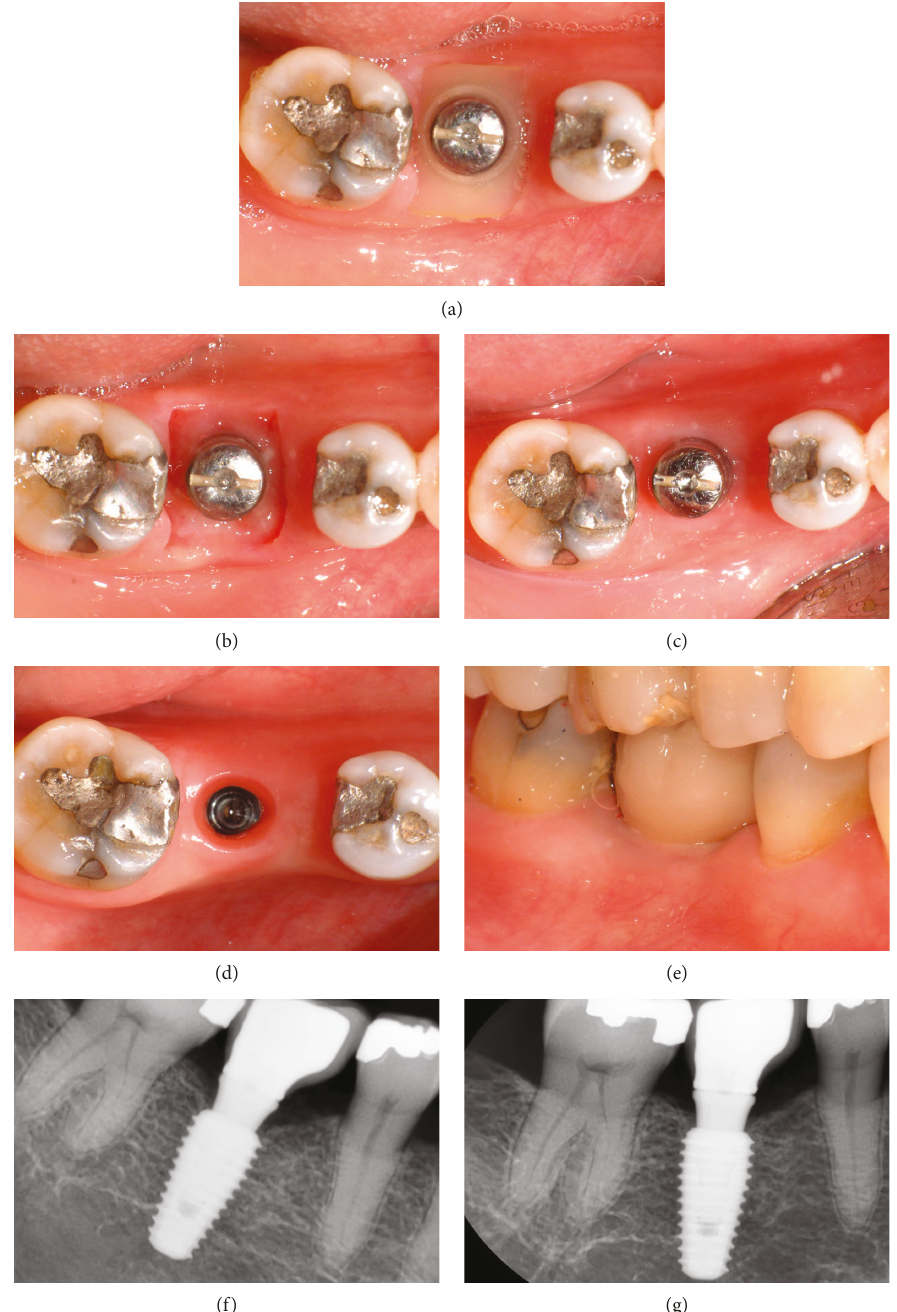
Figure 3: (a) Clinical condition before the removal of the silicone cap at 2 weeks postoperatively. (b) Soft tissue condition after the removal of the silicone cap at 2 weeks postoperatively. (c) Clinical condition at 2.5 months postoperatively. (d) Clinical condition at 6 months postoperatively before the application of the fi nal prosthesis. (e) Buccal view at 6 months postoperatively with the fi nal prosthesis. (f) Radiograph at 6 months postoperatively. (g) Radiograph at 22 months